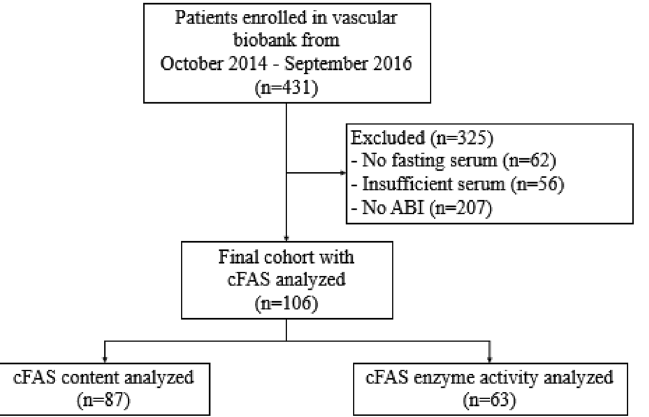
Figure 1. Flow diagram. Between October 2014 and September 2016, 431 patients were enrolled in the Washington University Vascular Surgery Biobank Repository. Patients who did not provide fasting serum (n = 62), had missing ABI (n = 207), or insufficient serum samples (n = 56) were excluded from this study. A total of 87 patients were included in this study and underwent analysis for cFAS content, while 63 patients underwent analysis for cFAS enzyme